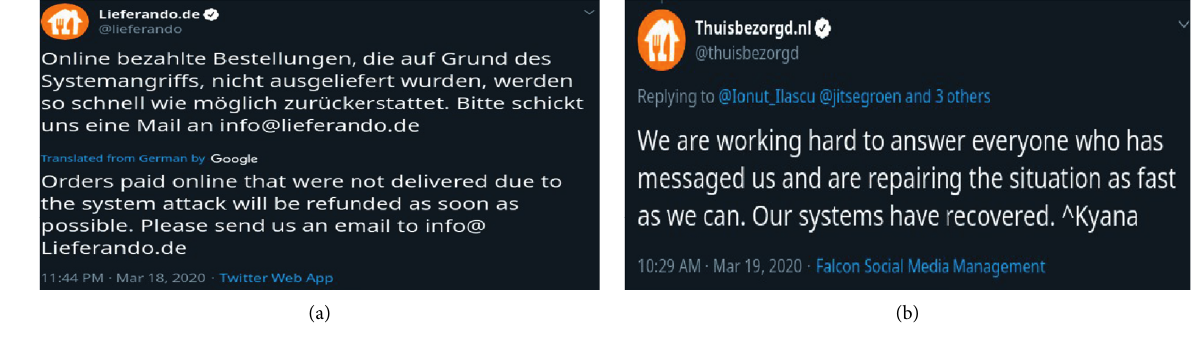
Figure 7: “Liefrando.de” food supplier tweets [33]. (a) “Liefrando” tweets for refunding orders. (b) “Liefrando” tweets for repairing the situation and accepting orders only.